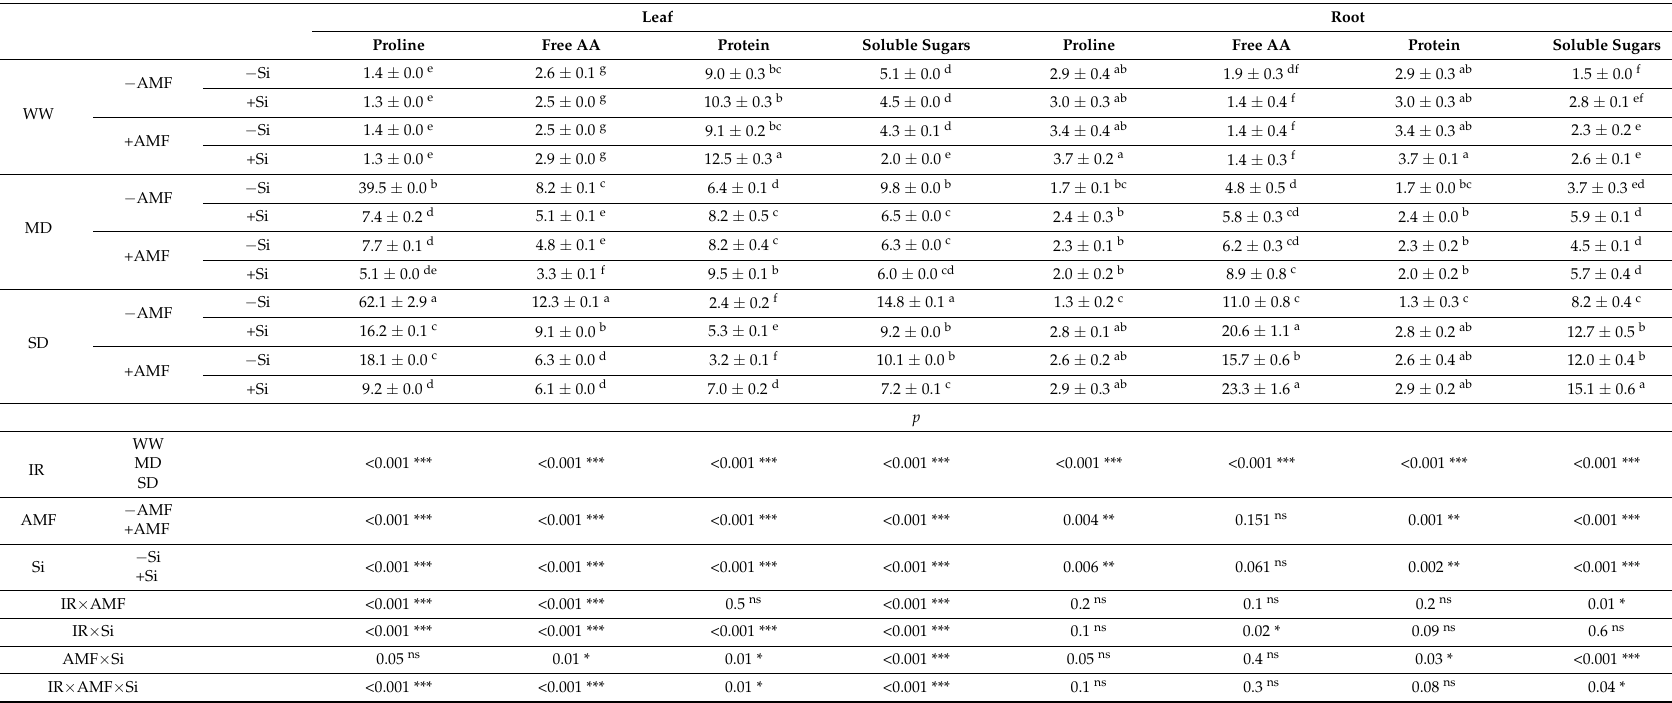
Table 2. The concentrations of proline ( µ g g − 1 FW), total free amino acids (AA, µ g g − 1 FW), total soluble proteins (mg g − 1 FW), and soluble sugars (mg g − 1 FW) in the leaf and roots of strawberry plants at harvest after six experimental weeks under three irrigation regimes (IR): well-watered (WW), mild drought (MD), and severe drought (SD) without ( − AMF) or with inoculation with arbuscular mycorrhizal fungus (+AMF) Rhizophagus clarus (Walker & Schüßler), in the absence ( − Si) or presence of silicon (+Si, 3 mmol L − 1 Na 2 SiO 3 ). The numbers show the treatment means (4 replicates) ± SE of the mean. Means with the same letters are not significantly different. Interactions among the main factors are indicated as *** p < 0.001, ** p < 0.01, and * p < 0.05 and ns as not significant (Tukey test, alpha =